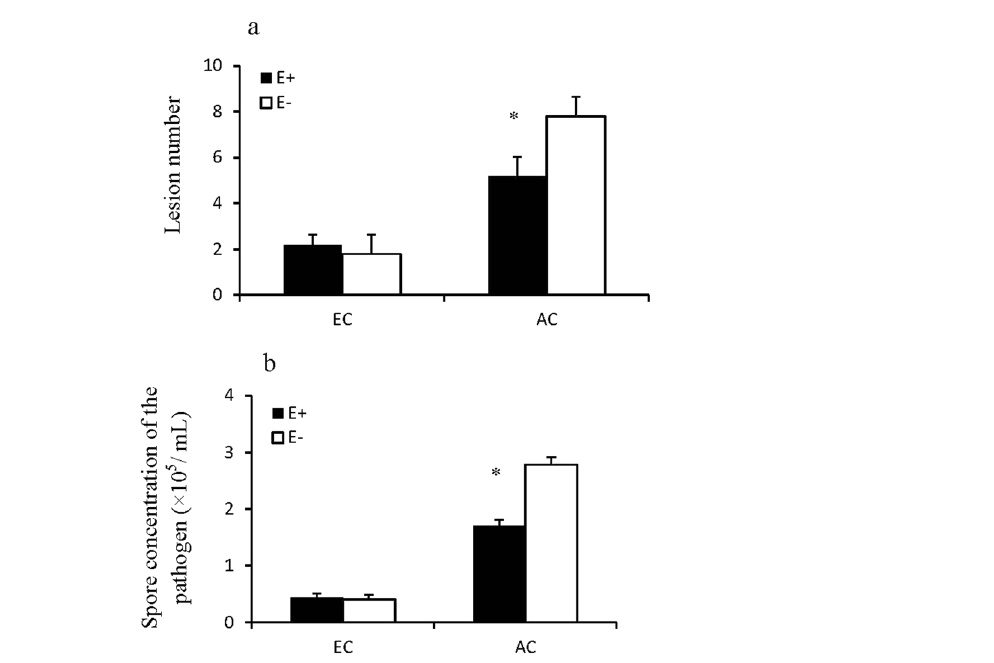
Figure 4. Lesion number ( a ) and pathogen spore concentration ( b ) of endophyte-infected (E + ) or